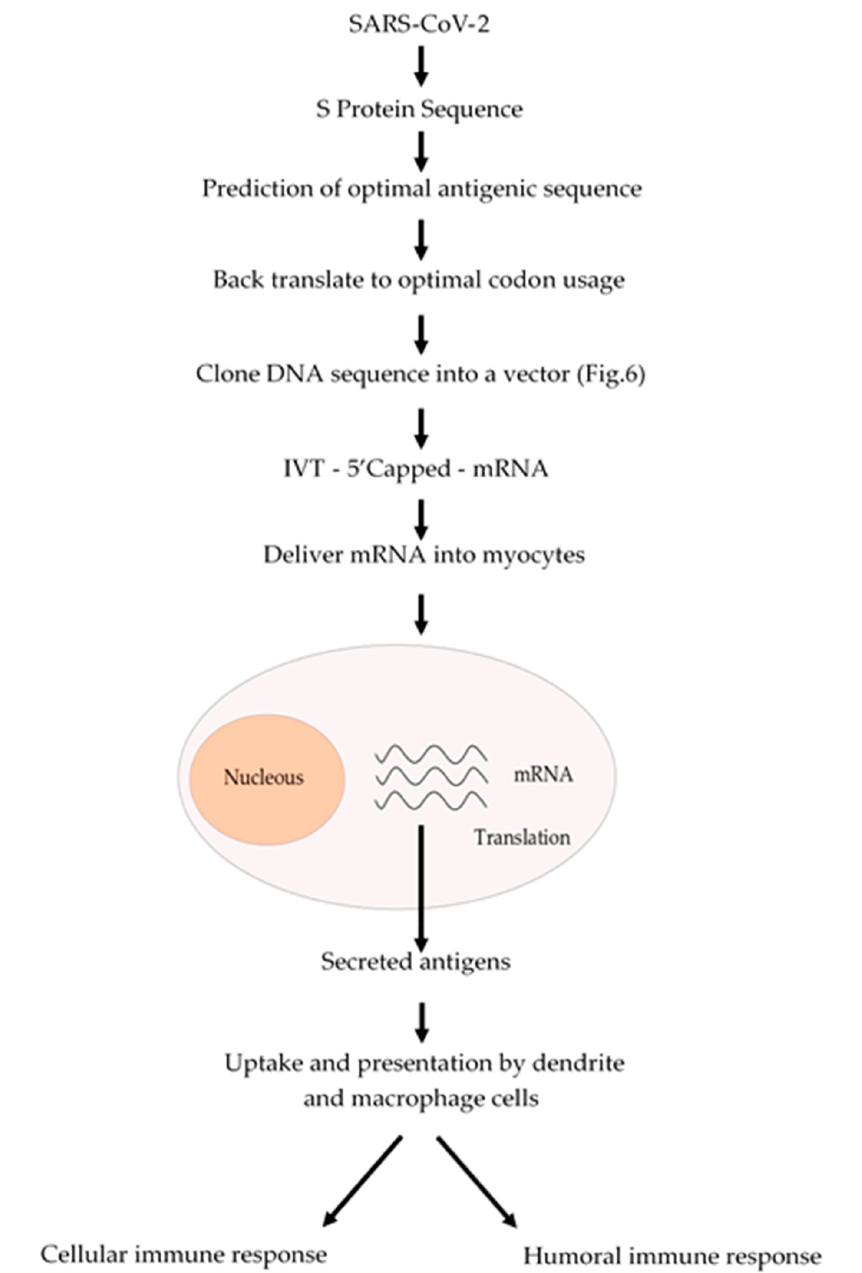
Figure 5. Schematic procedure to produce an mRNA vaccine against SARS-CoV-2. From the analysis of the amino acid sequence of the S protein an antigenic region can be predicted. Whenever possible, a region of the S protein which is less prone to mutations should be selected. The amino acid sequence of the selected region can be back translated to DNA nucleotide sequence and it can be chemically synthetized according to the codon usage. Afterwards, this DNA sequence can be cloned into a DNA plasmid vector, as described in Figure 6, and used for in vitro transcription (IVT) by using a RNA polymerase to produce an mRNA that can be 5 (cid:48) capped to be fully functional. This mRNA can be coated with lipid nanoparticles and delivered to the myocytes to be translated by the cell ribosomes. The resulting antigens will be secreted and take up by macrophages and dendritic cells, which will process and present the antigen to the immune system cells to activate both humoral (antibodies) and cellular (cytotoxic) immune